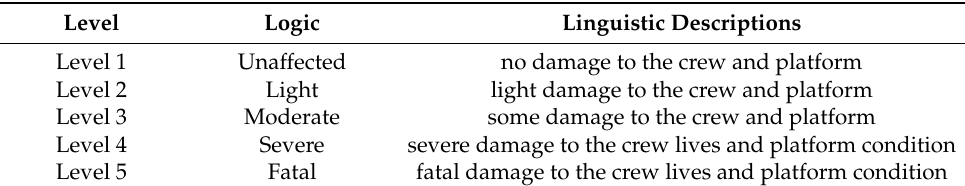
Table 3. Evaluation criterion of consequence severity.